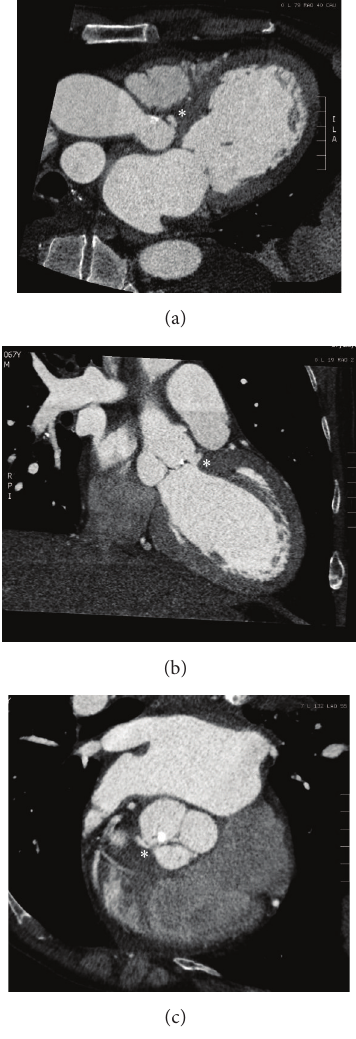
Figure 4: Multiplanar, reformatted oblique views of cardiac CTA (a, b, c) demonstrating the small pseudoaneurysm ( ∗ ) involving the aortic annulus and the mitral-aortic intervalvular